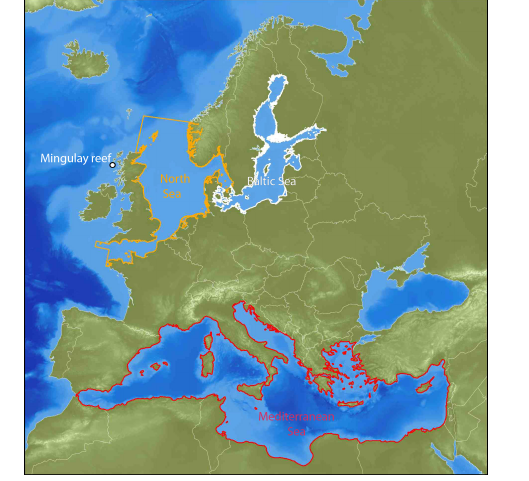
Fig. 4. Choke point case study